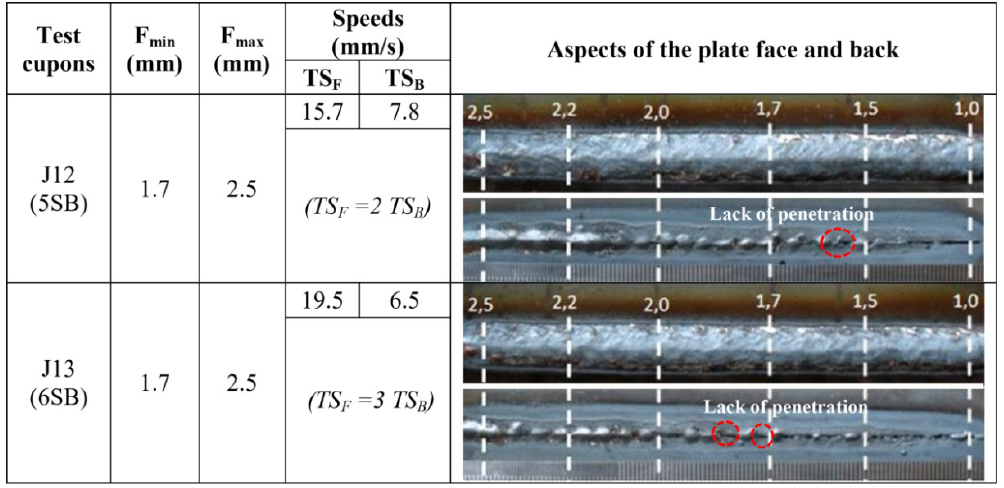
Figure 7. Quantification of the operational gap range for experiments 5SB and 6SB (switchback torch movement), where TS F > TS B .